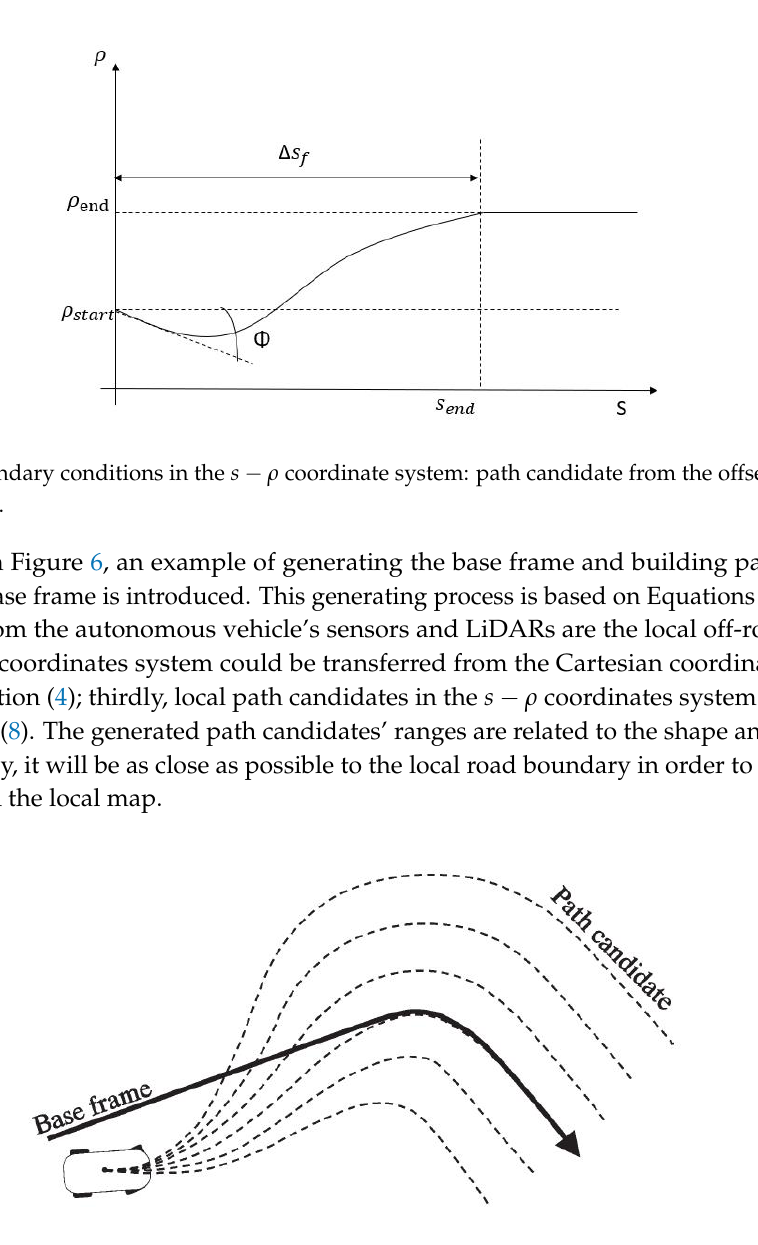
Figure 6. Example of the generated base frame and path